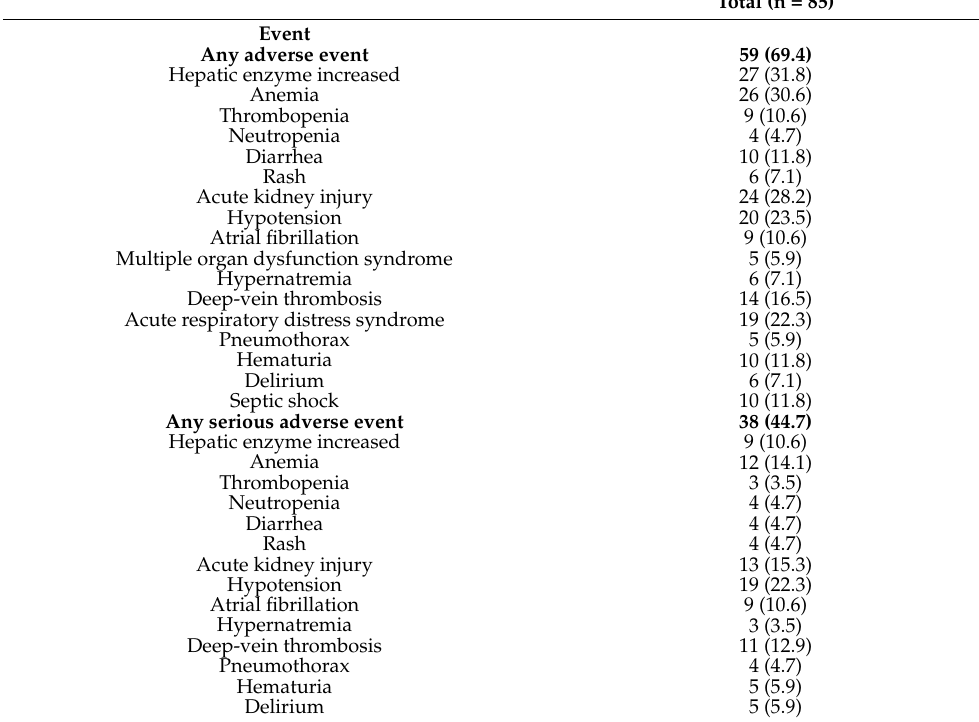
Table 4. Adverse